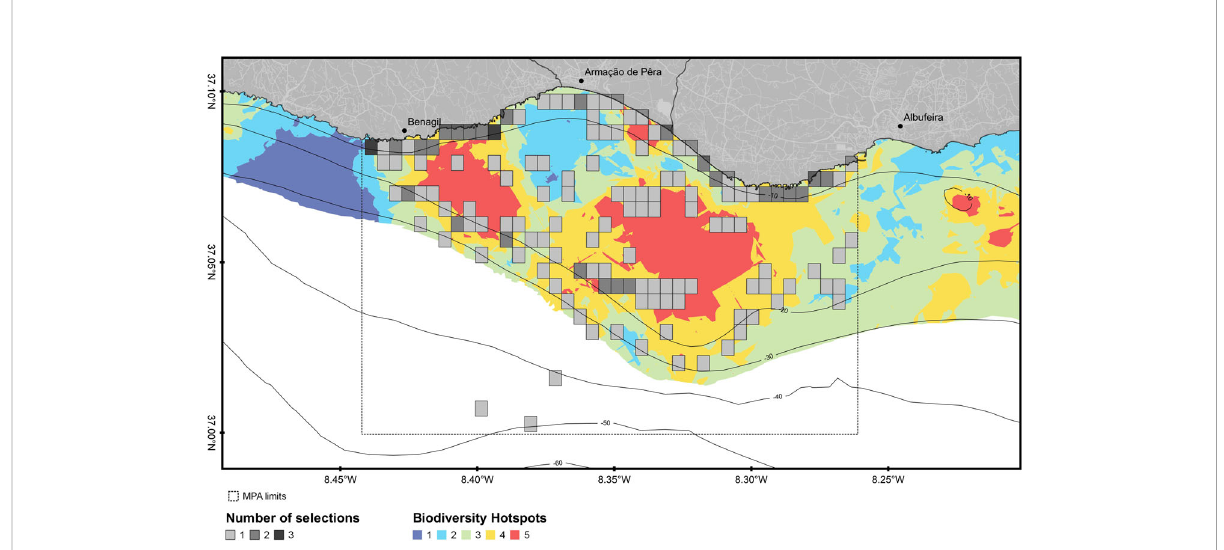
FIGURE 5 Overlap of the ecological features captured by the biodiversity hotspots and the users ’ map in the region of the future MPA. See Figures 3, 4 for details on the number of selections and the biodiversity